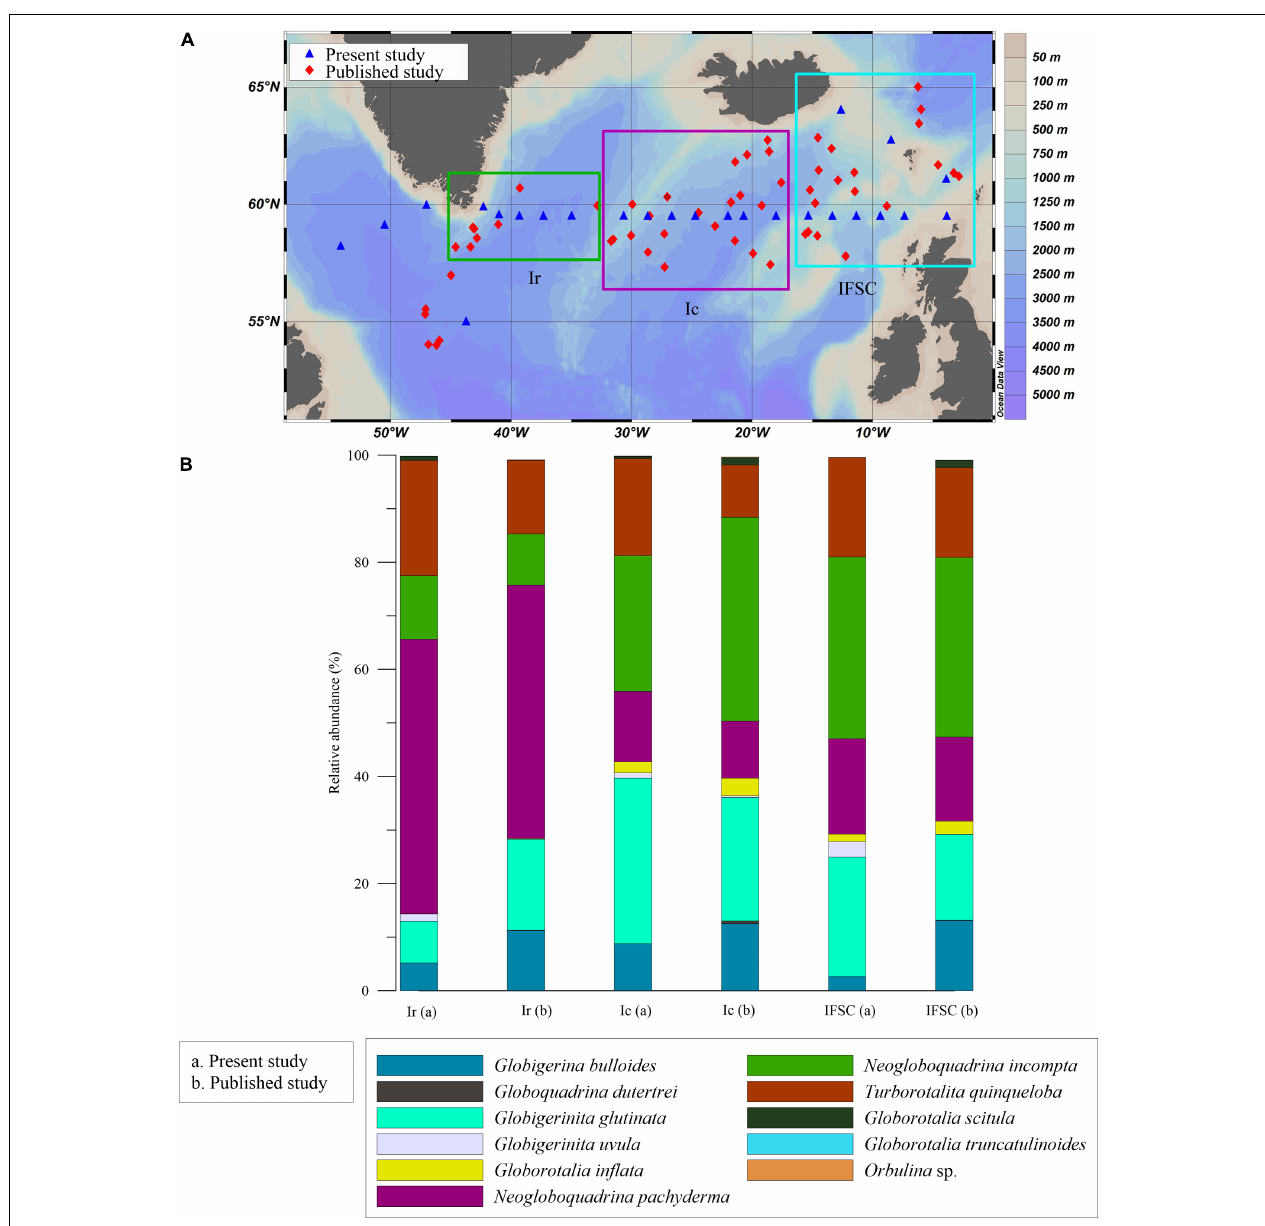
FIGURE 9 | (A) Map showing locations of the samples from Matul et al. (2018) (red diamond) and from our study (blue triangle). (B) Comparison of the relative abundance (%) of planktic species from this study (a) with Matul et al. (2018) (b), shown in the bar chart; Ir, Irminger Sea; Ic, Iceland Basin; IFSC, Rockall Plateau and Iceland-Faroe-Shetland